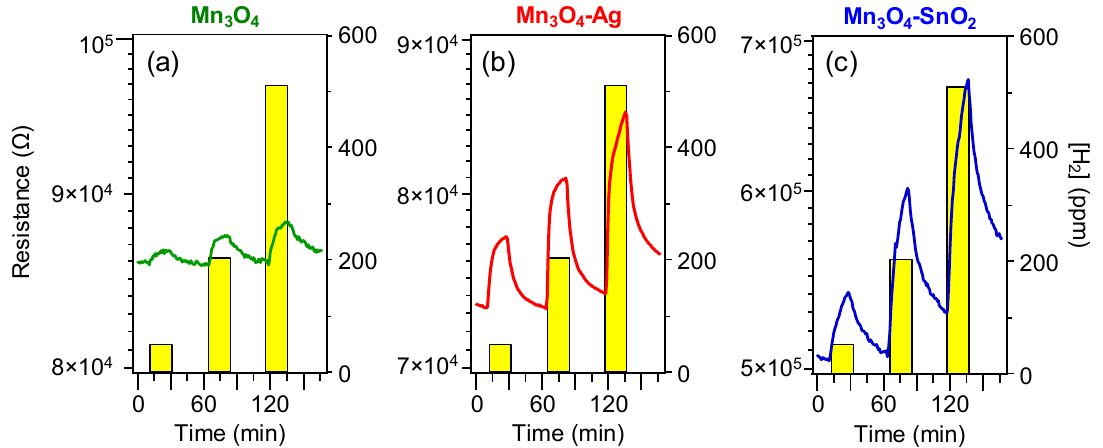
Figure 6. Dynamical responses of Mn 3 O 4 ( a ), Mn 3 O 4 -Ag ( b ) and Mn 3 O 4 -SnO 2 ( c ) nanosystems vs. different H 2 concentrations, at a fixed working temperature of 200 °C.